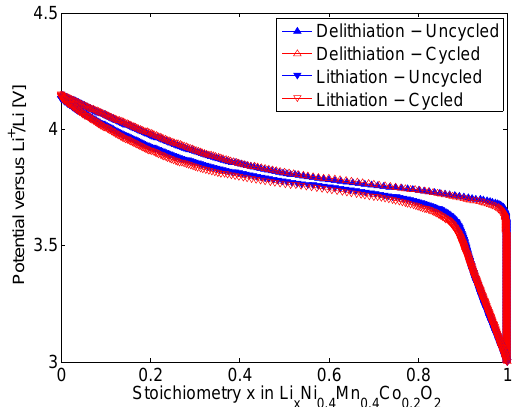
Figure 2. Uncycled and cycled Nickel Manganese Cobalt (NMC) equilibrium potential versus